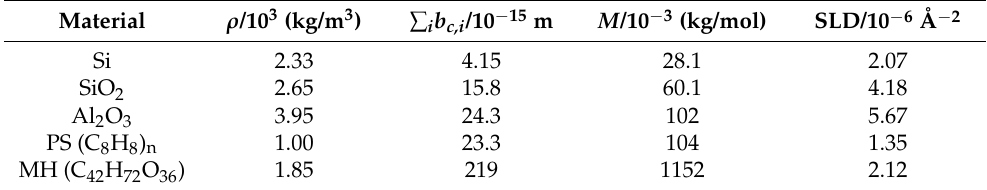
Table 1. Calculated scattering length density SLD from theoretical density ρ , neutron bound coherent scattering length b c [26,27], and molar mass M for relevant materials.